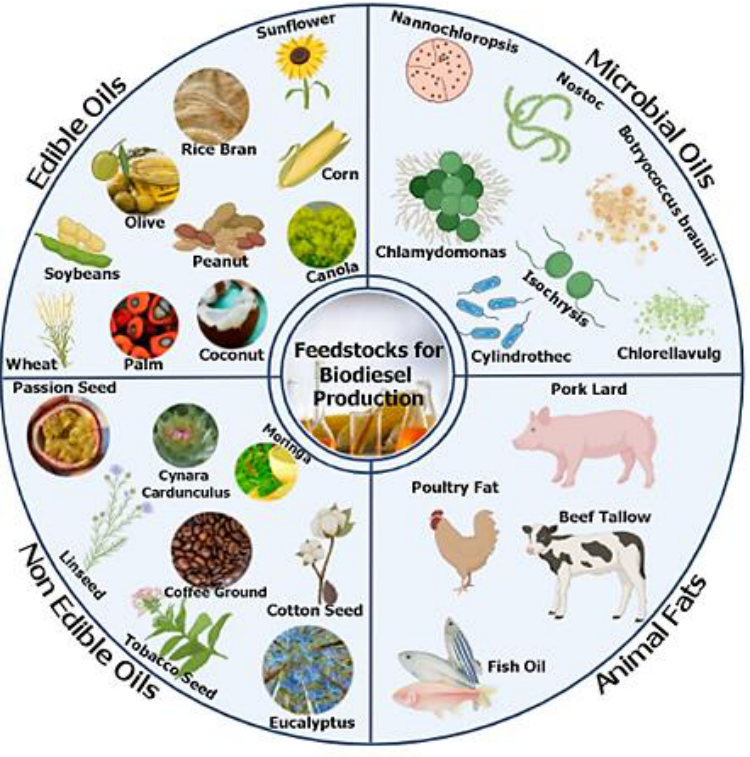
Figure 10. Various feedstocks used in the production of biodiesel. These are divided into four classes: edible oils, inedible oils, microbial oils, and animal fats.